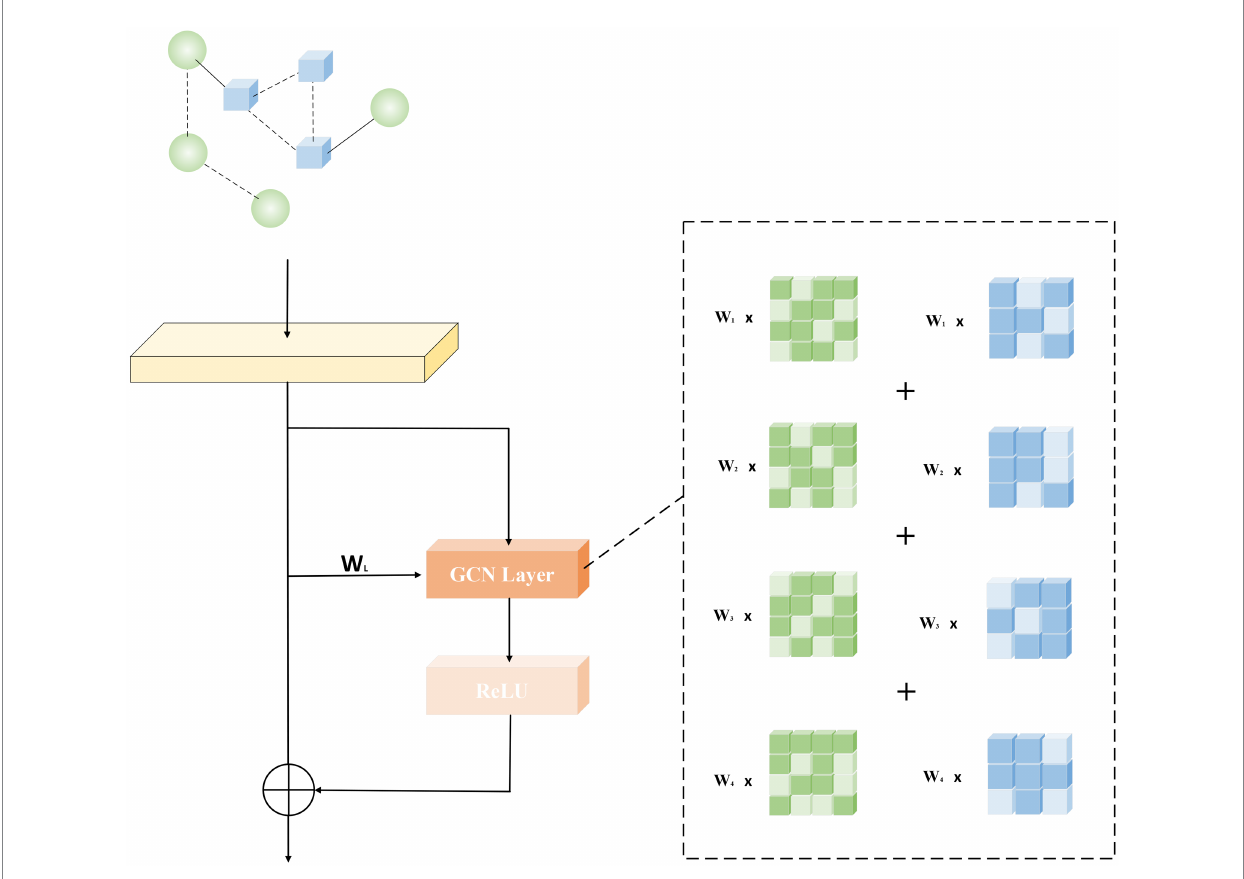
FIGURE 2 Generate network core model structure